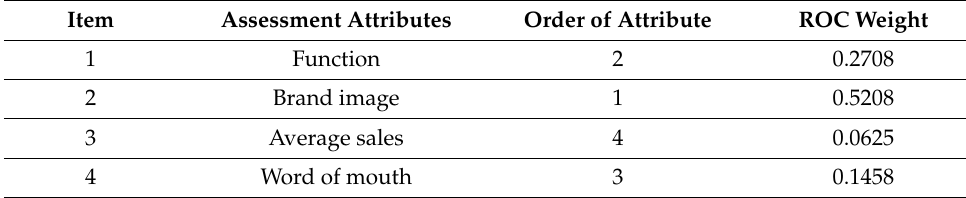
Table 8. The attribute weights.